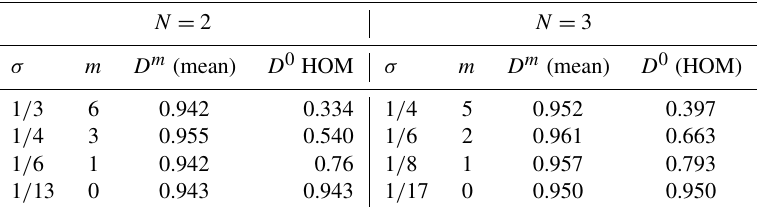
Figure 5. Response of the fundamental mode in the scaled coordinates as a function of the number of iterations and the smoothing parameter. (a) 2D LiSBOA and (b) 3D LiSBOA. The white crosses indicate the pairs σ − m provided in Table 2. Table 2. Selected combinations of σ and m for achieving a ∼ 95% recovery of the mean of the selected fundamental half wavelength and associated response of the higher-order moments